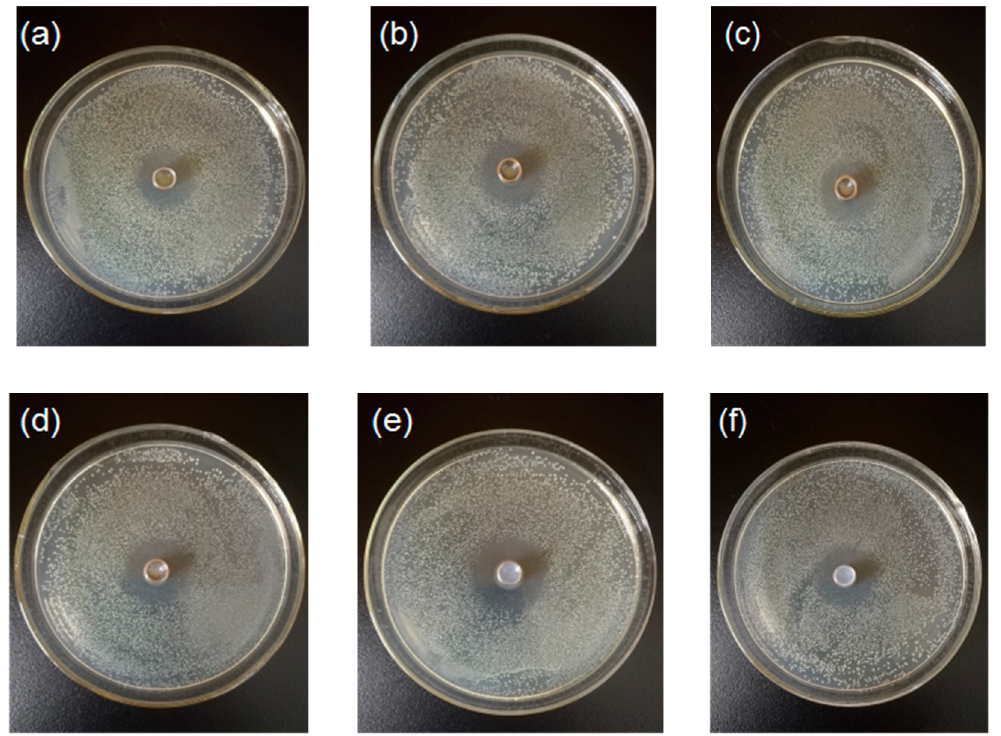
Figure 10. Inhibition zone for S.aureus after the treatment by the chitosan-based coating film with TiO 2 nanoparticles ( a ) 0; ( b ) 0.01%; ( c ) 0.03%; ( d ) 0.05%; ( e ) 0.07%; ( f ) 0.09%.